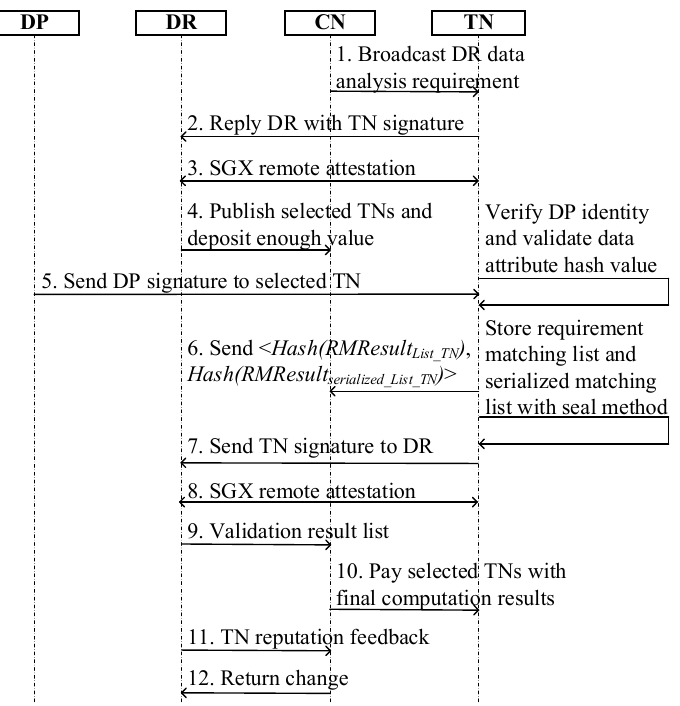
Figure 4. The requirement matching phase of SPPCS.